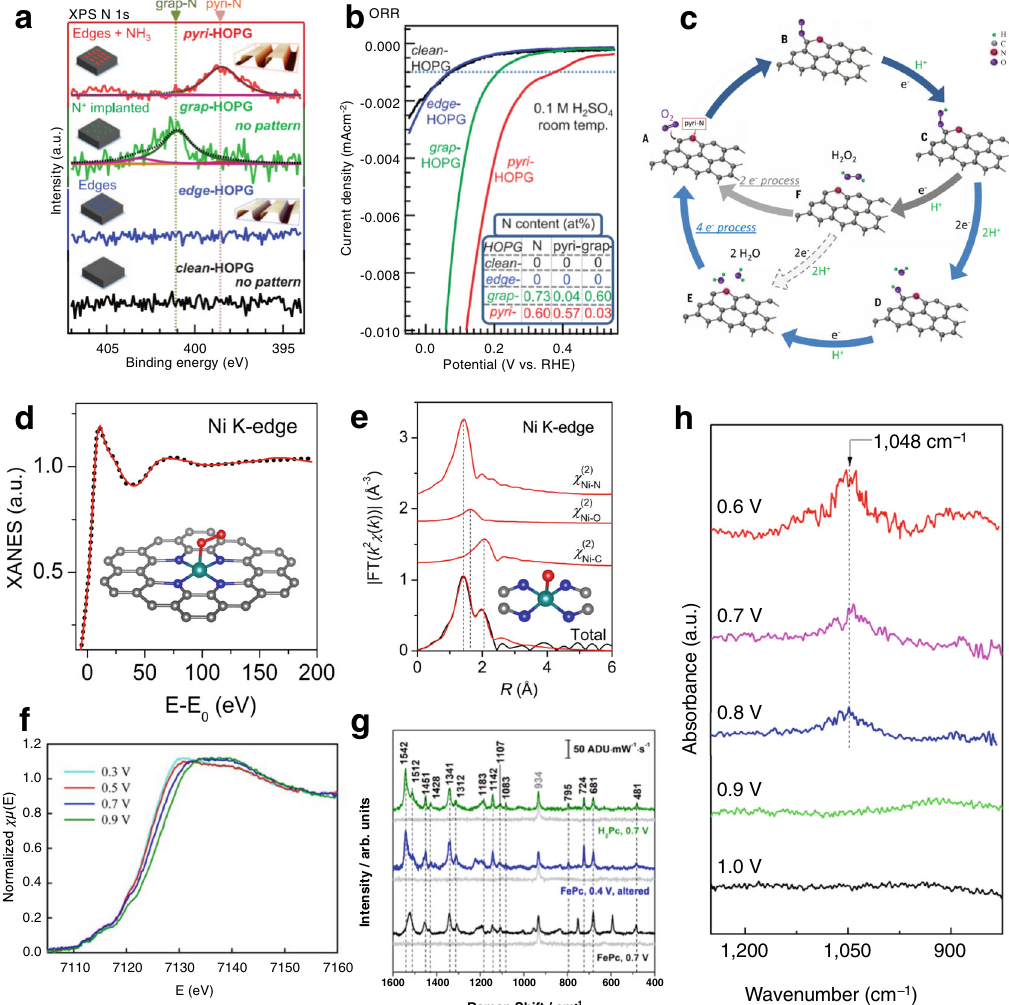
Fig. 3 Spectroscopic data from EN studies. a N 1 s XPS spectra, and b linear sweep voltammograms of HOPG electrodes functionalized with pyridinic (red) and quaternary (green) nitrogen and unfunctionalized edge-plane (blue) and cleaned basal plane (black) HOPG. Adapted and reprinted with permission from ref. 58 . c The proposed reaction mechanism where O 2 adsorbs onto the carbon adjacent to the pyridinic nitrogen to form structure B, which then undergoes a series of PCET steps to form either H 2 O 2 or H 2 O 58 . d Theoretical fi tting (red lines) of EXAFS spectra for an Ni-doped SAC with O 2 adsorbed on the metal site. Reproduced with permission from ref. 63 . e Ni K-edge FT-EXAFS belonging to a Ni-SAC showing the experimental spectra (black) and best fi t (red) from the inset model along with contributions from, top to bottom, Ni – N, Ni – O, and Ni – C scattering. Reproduced with permission from ref. 63 . f In situ Fe K-edge XANES of an Fe-SAC at anodic potentials approaching and surpassing the onset of ORR. Adapted and reprinted with permission from ref. 62 . g In situ Raman of FePC molecules deposited on a gold TERS substrate working electrode at 0.7 V (unaltered, bottom plot) and 0.4 V (altered, middle plot) with H 2 Pc at 0.7 V for comparison. Adapted and reprinted with permission from ref. 71 . h Operando SR-FTIR measurements recorded during ORR for a NiFe-co-doped MOF. A potential-dependent band arises at 1048 cm − 1 and continues to grow as potentials become more negative. Adapted and reprinted with permission from ref. 70